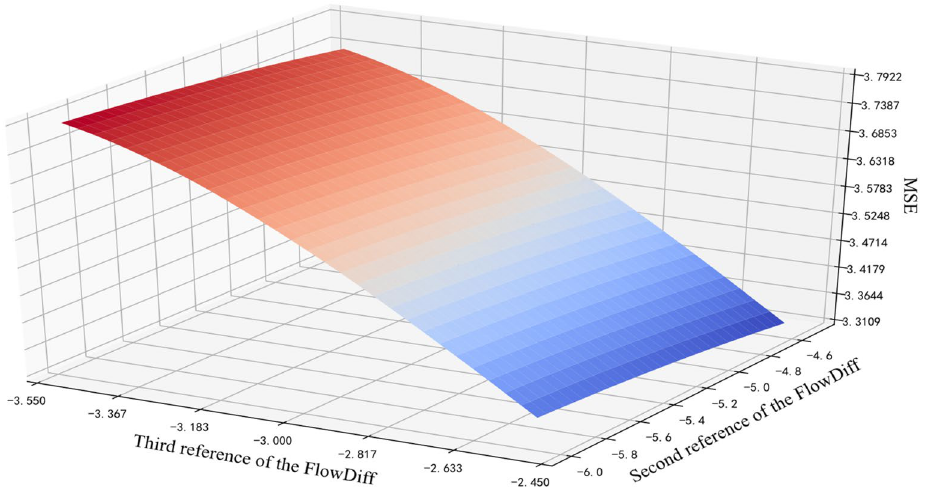
Figure 4. Calculated MSEs of the interval referential values in BRB.